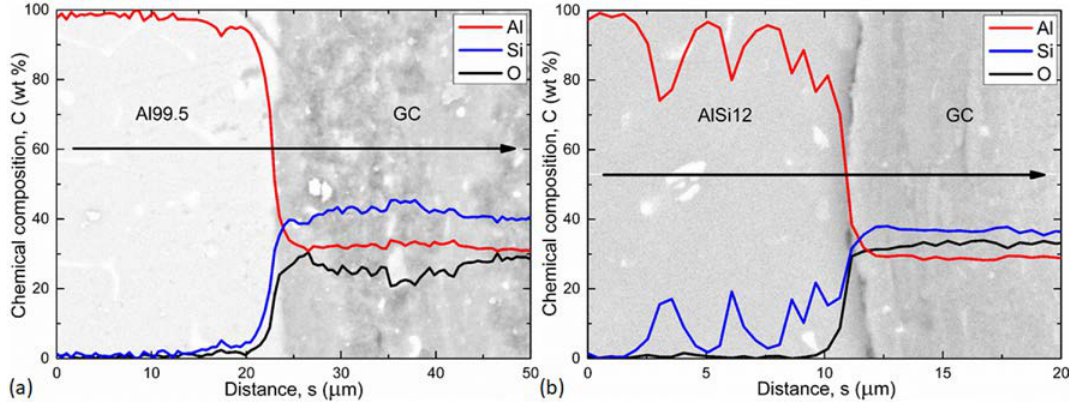
Figure 3. Line EDS element profiles of ( a ) Al99.5-based and ( b ) AlSi12-based MMSFs.